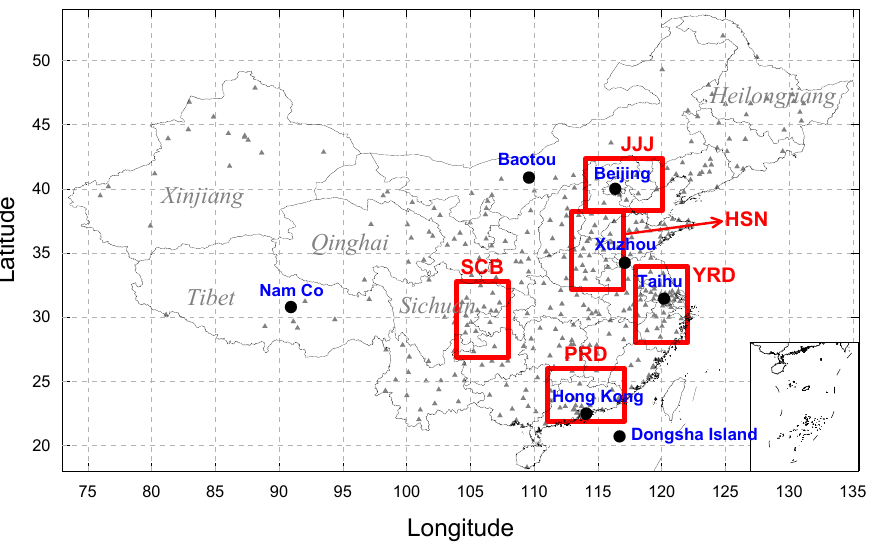
Figure 1. Study area and location of validation sites. The small grey triangles indicate in situ fine particulate matter (PM 2.5 ) stations, and the larger black dots pinpoint the AERONET ground-based sites. The boxes represent the polluted areas selected in China, including Beijing-Tianjing-Hebei (JJJ), Hebei-Shandong-Henan (HSN), Yangtze River Delta (YRD), Pearl River Delta (PRD) and Si-Chuan Basin (SCB).